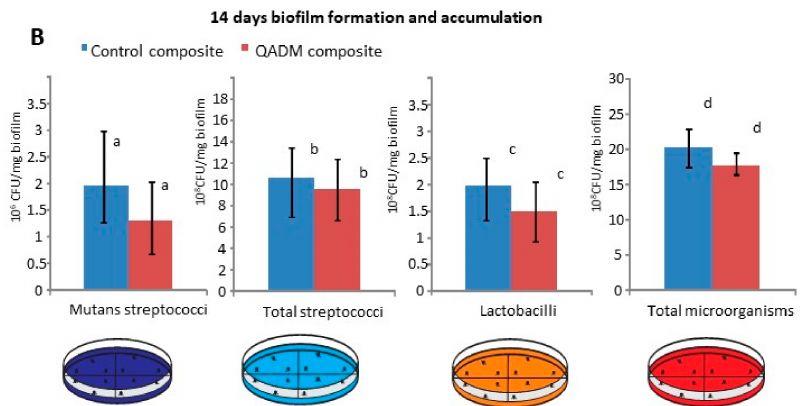
Figure 1. ( A ) Colony-forming unit (CFU) counts for the viability of mutans streptococci (MS), total streptococci (TS), lactobacilli, and total microorganisms (TM) present in the biofilms formed in situ after a 7-day and ( B ) 14-day period. Error bars represent the standard deviation of the mean, and data followed by different letters differed statistically ( p < 0.05). The reduction in CFU counts from biofilms adherent to the QADM (bis(2-methacryloyloxyethyl) dimethylammonium bromide) composites was significantly different from the control for Streptococcus mutans after 7 days of growth. After 14 days, no further reduction was observed for S. mutans .